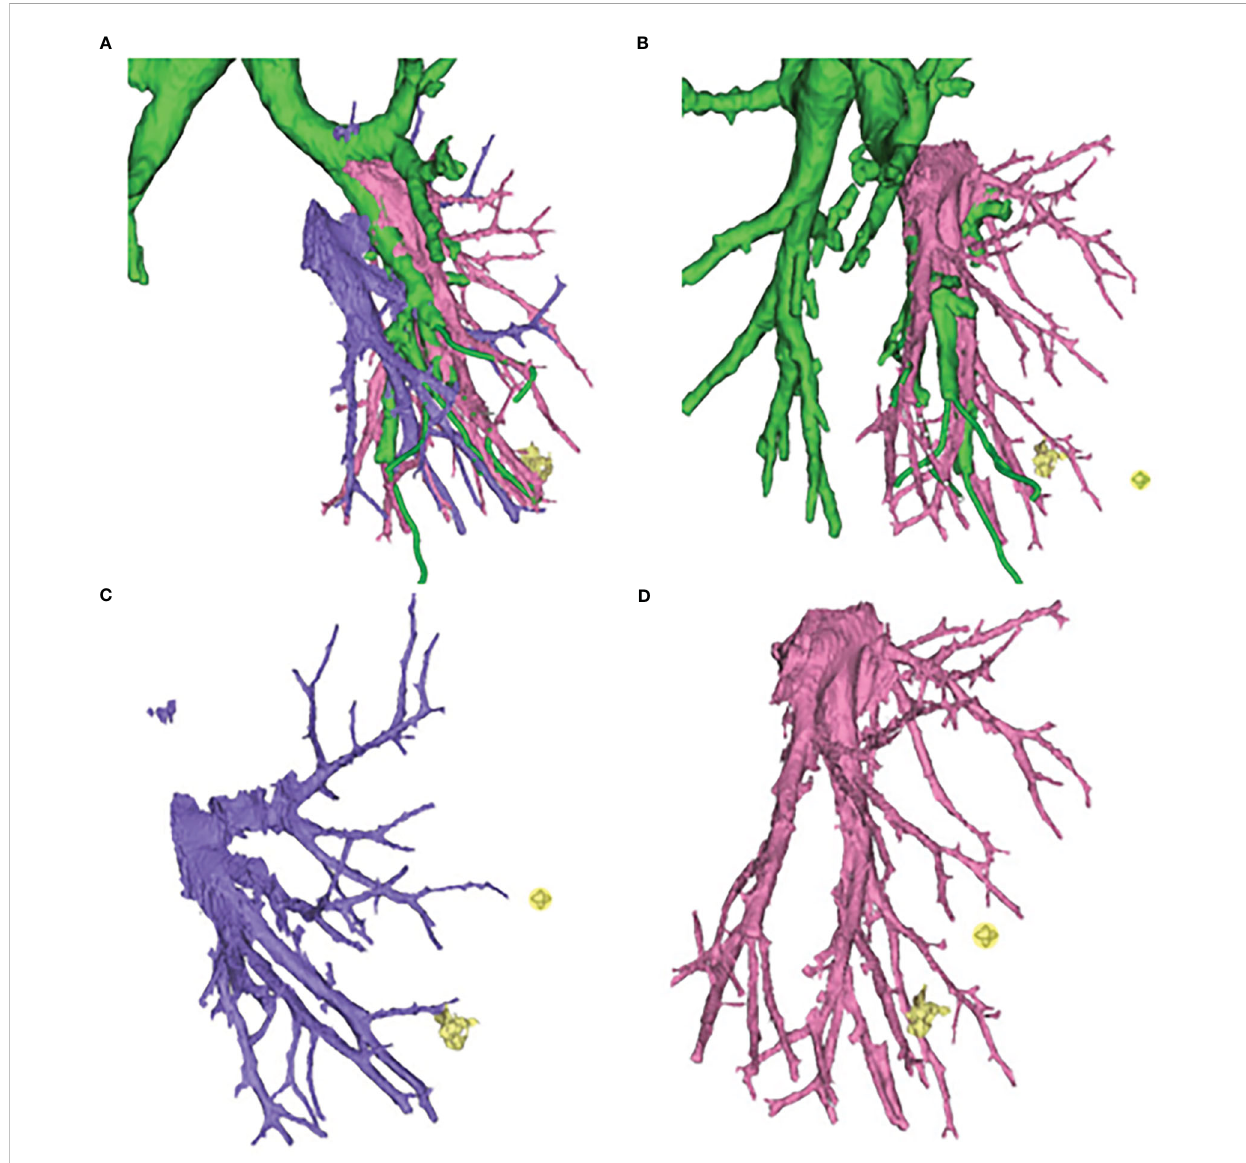
FIGURE 3 Three-dimensional computed tomography-bronchography and angiography (3D-CTBA) for GGO in S9. (A) Bronchi, artery and vein. (B) Bronchi and artery. (C) vein. (D)